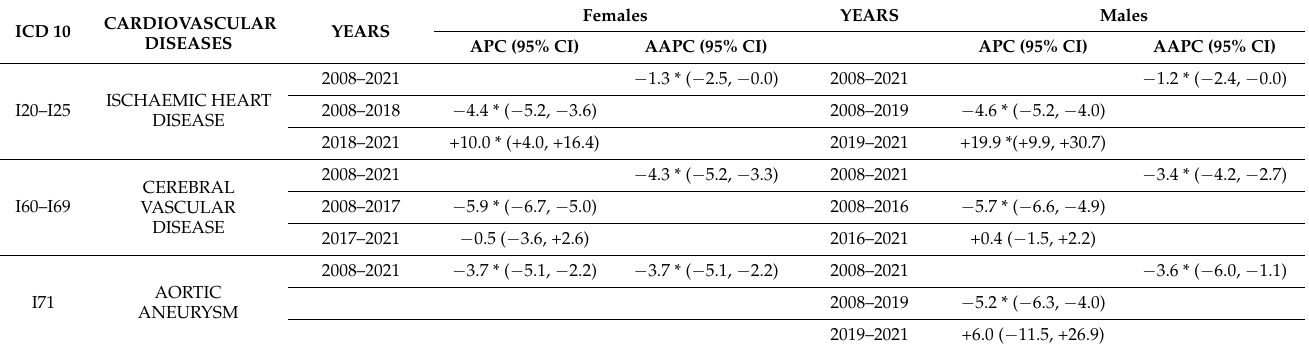
Table 3. Time trends of standardized mortality rates due to the analyzed groups of cardiovascular diseases.